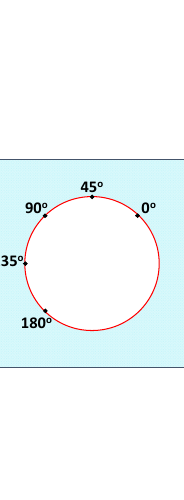
Figure 9. Typical void contour at DNB.